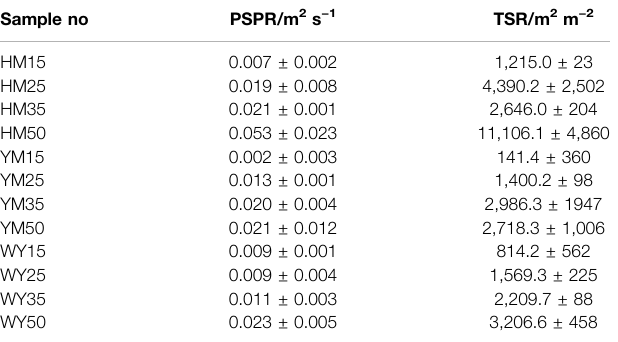
TABLE 4 | The related smoke release data of coal